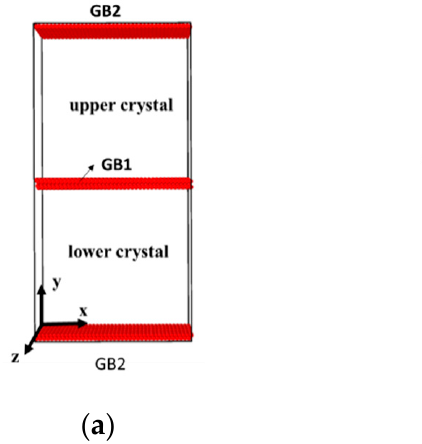
Figure 1. ( a ) Schematic of the bicrystal model, with two identical GBs in the model because the periodic boundary condition is applied in the y-direction. ( b ) Atomic configuration of a symmetrically tilted GB; the upper and lower crystals are rotated at the same angle but in opposite directions.